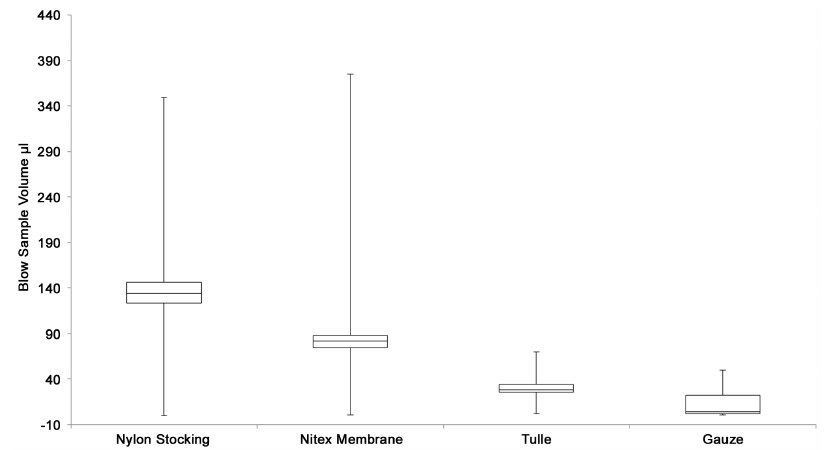
Figure 1. Volumes of blow samples recovered from nylon stocking, nitex (nylon) membrane, tulle netting and gauze following 4 exhales. For each collection material sample collection data are pooled for three animals. Largest volumes were collected from nylon stocking and nitex